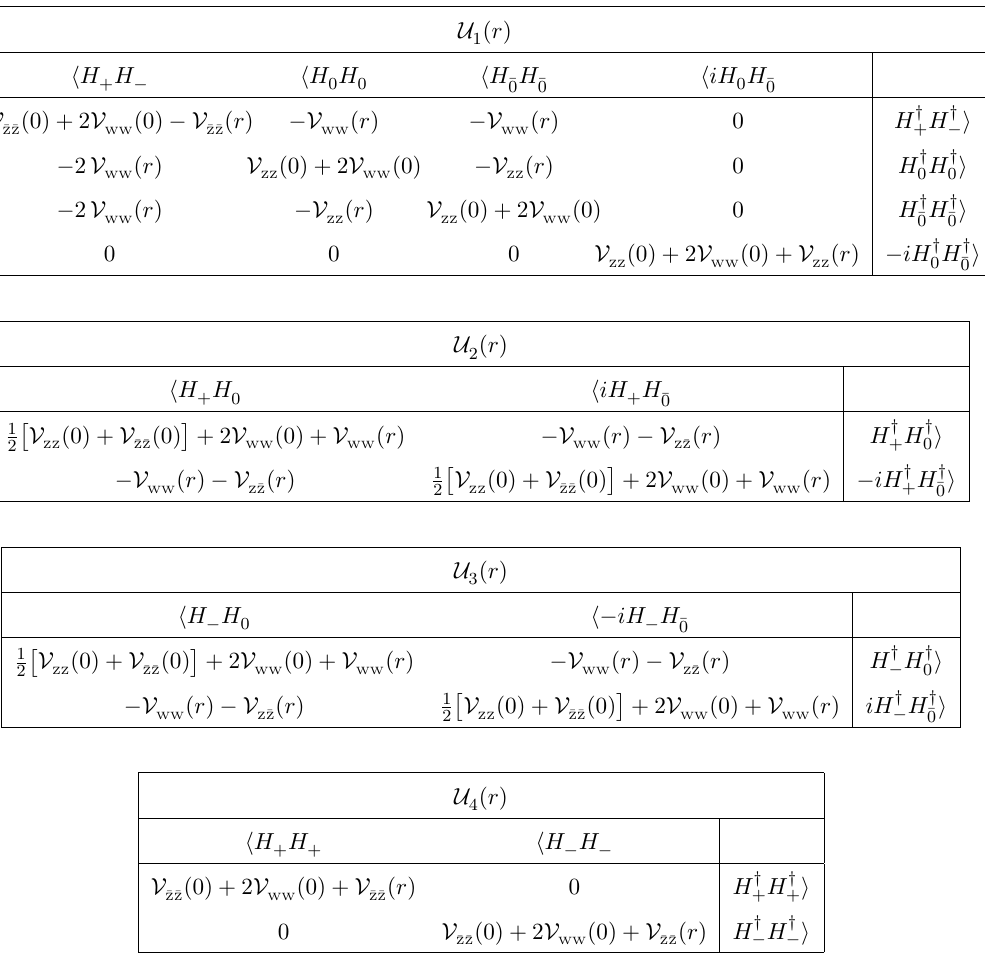
Table 1 . The \potentials" U appearing in eq. (4.37). In general the potentials contain both a real i part, as well as an imaginary part representing thermal scatterings (cf. eq. (4.15) and section